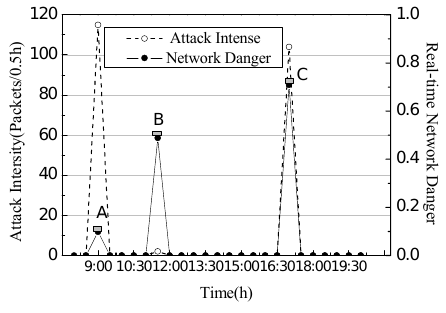
Fig. 4. The attack curve and the damage degree curve